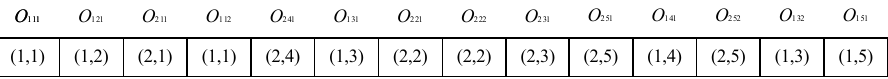
Figure 3. The OP segment after the repair